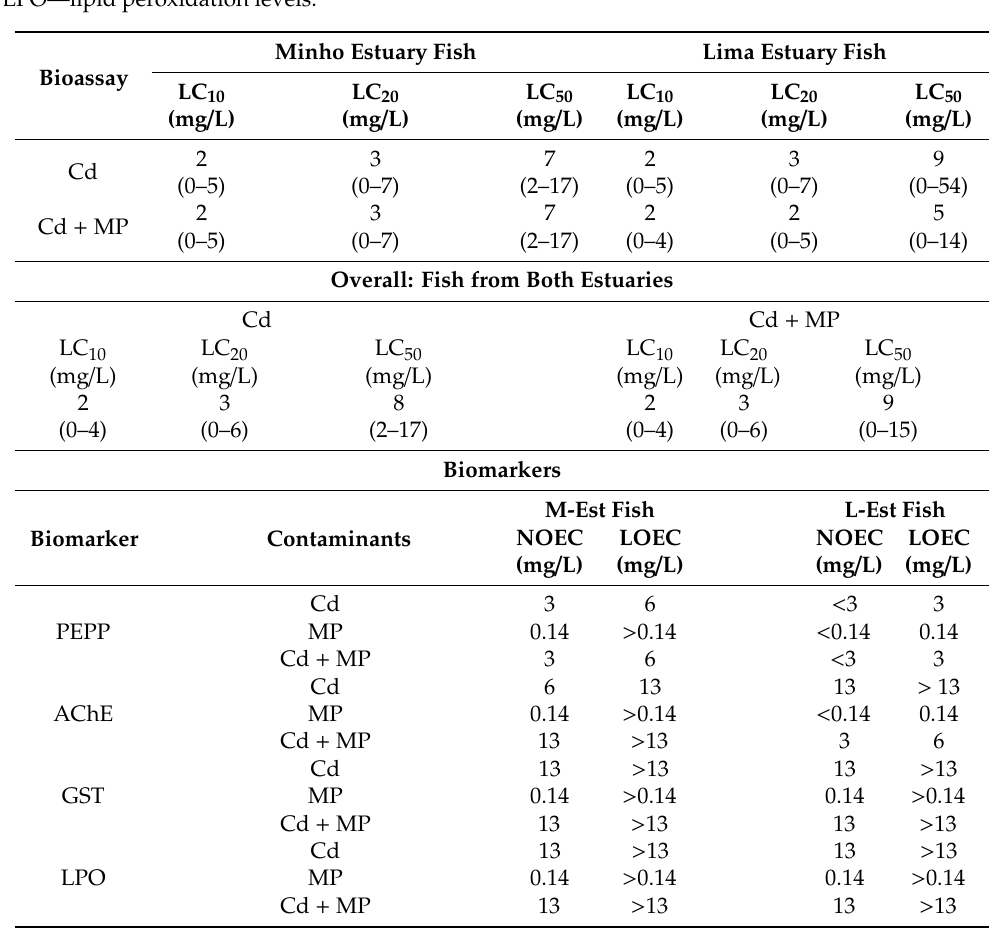
Table 1. Estimated 96 h lethal concentrations (LC 10 , LC 20 and LC 50 of cadmium alone (Cd) and in mixture with microplastics (Cd + MP) to Pomatochistus microps juveniles from the estuaries of Minho and Lima Rivers with corresponding 95% confidence interval within brackets, and results of the Analysis of Covariance for several comparisons are also shown. No observed e ff ect concentrations (NOEC) and lowest observed e ff ect concentrations (LOEC) of Cd and MP alone, and of Cd in mixture with MP (Cd + MP) for biomarkers. Variab. Contrib.—contribution to total variance;